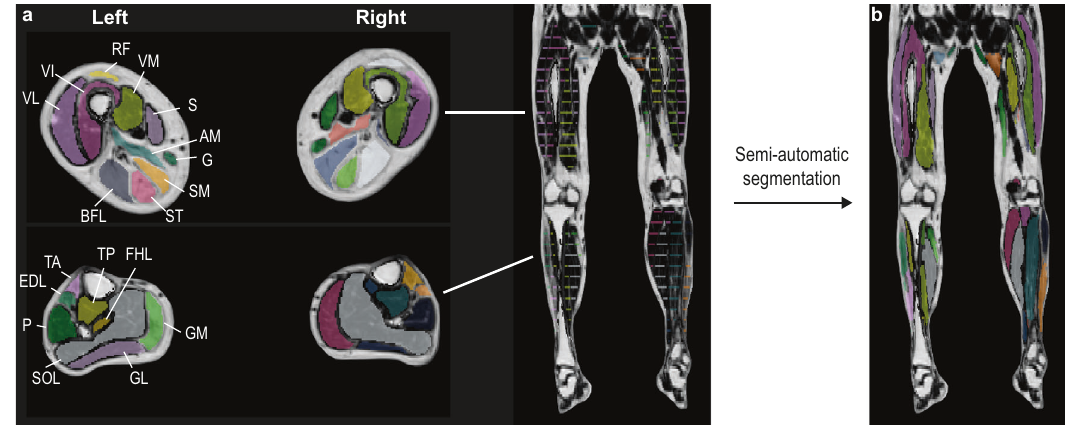
Fig. 1 Overview of manual and semi-automatic segmentations of lower extremity muscles displayed on fat fraction maps. Each muscle was manually segmented at every fi fth measured slice from its distal to the proximal end ( a ). The slices were then propagated, as published by Ogier et al. (2017), to segment all remaining slices ( b ). As a result, all muscles were segmented on every slice (every 5 mm). The colours represent the different muscles. Upper leg muscles: AM adductor magnus, BFL biceps femoris long head, G gracilis, RF rectus femoris, S sartorius, SM semimembranosus, ST semitendinosus, VI vastus intermedius, VL vastus lateralis, VM vastus medialis. Lower leg muscles: EDL extensor digitorum longus, FHL fl exor hallucis longus, GM gastrocnemius medialis, GL gastrocnemius lateralis, P peroneus, SOL soleus, TA tibialis anterior, TP tibialis fat fraction change (follow-up fat fraction – baseline fat fraction) and fat fraction change per year (follow-up fat fraction – baseline fat fraction/follow-up time in years).